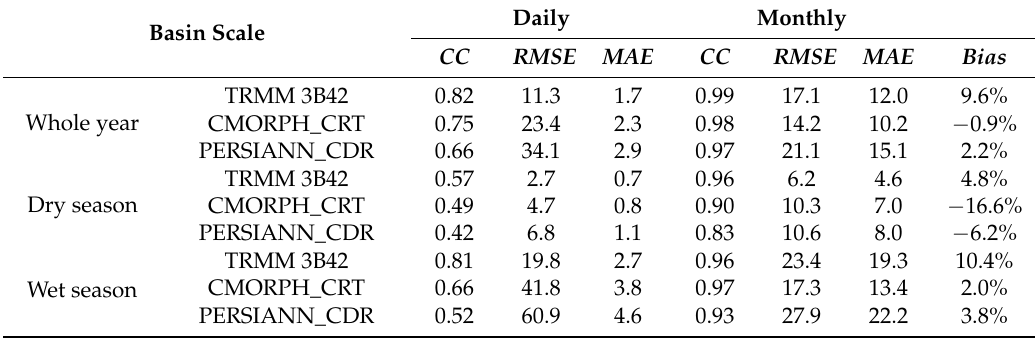
Table 4. Statistical indices between three satellite-based precipitation products (SPPs) and rain gauge data at the basin scale.